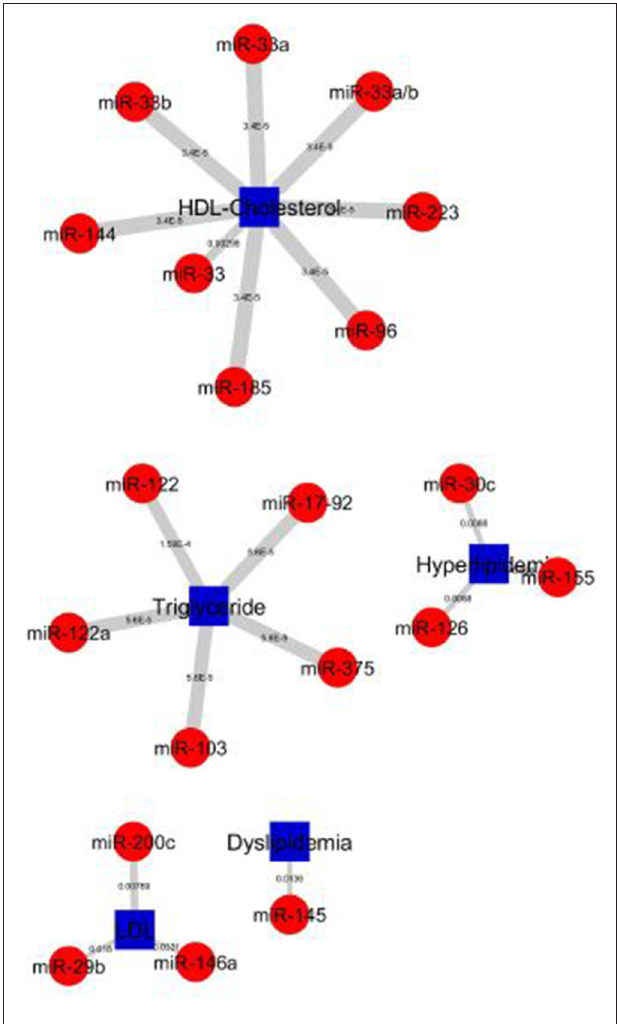
FIGURE 6 | Top 20 miRNA-lipid disease association of P -values. Red circles and green circles represent miRNAs and diseases, blue square represents lipid diseases/identifiers, respectively, according to the number of corresponding, text-mined annotated papers. Each linked pair represents an miRNA-disease association with edge-weighted measurement by P -values to visualize the strength of the miRNA-disease association. The higher strength is shown in HDL-Cholesterol and Triglyceride groups paired with miRNAs.